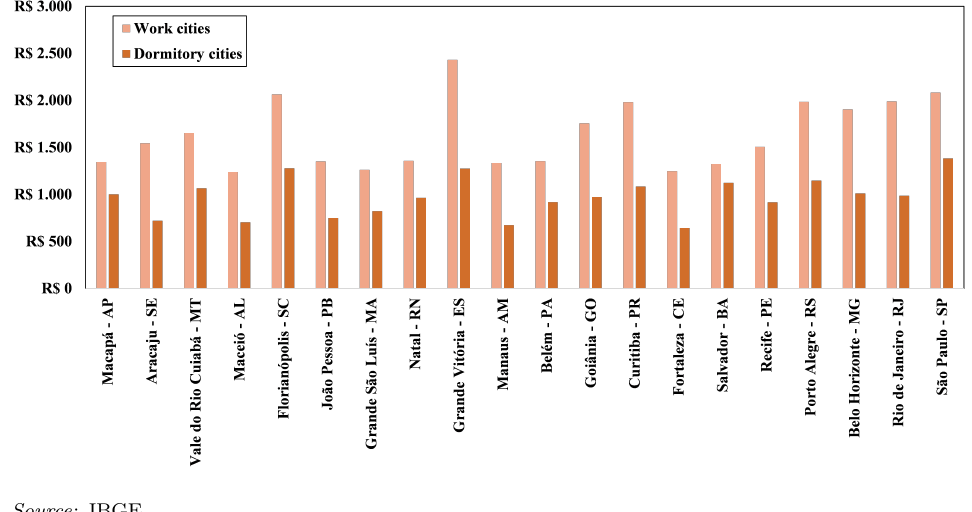
Figure 3: Average monthly wage for workers who live in work or dormitory cities inside each metropolitan area, (ordered by the size of working population), 2010